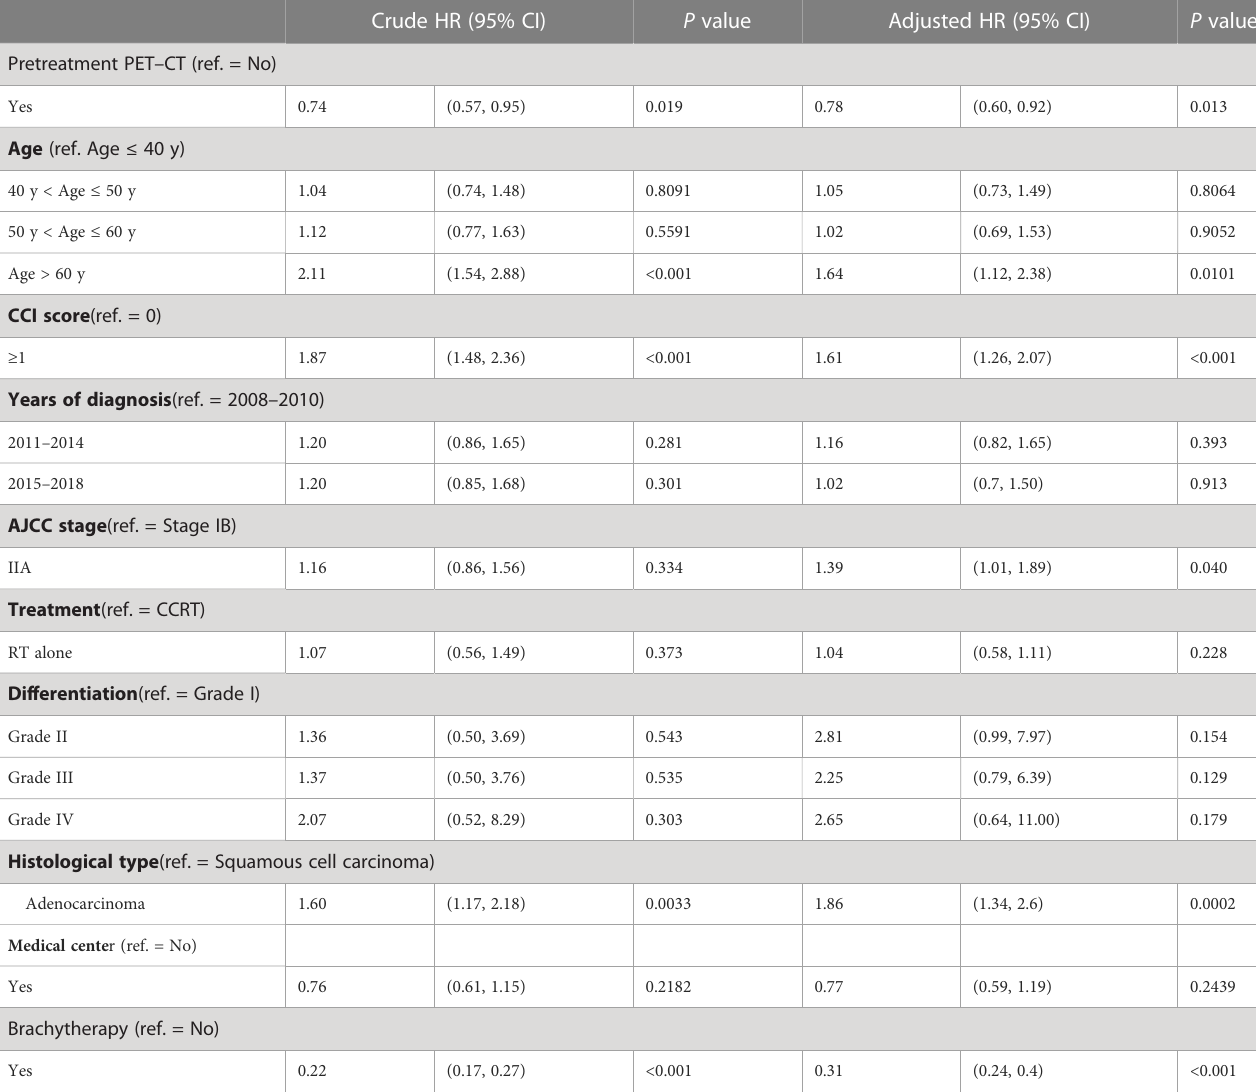
TABLE 3 Cox proportional hazard regression analysis of the risk of all-cause death in propensity score – matched patients with AJCC stage IB – IIA cervical